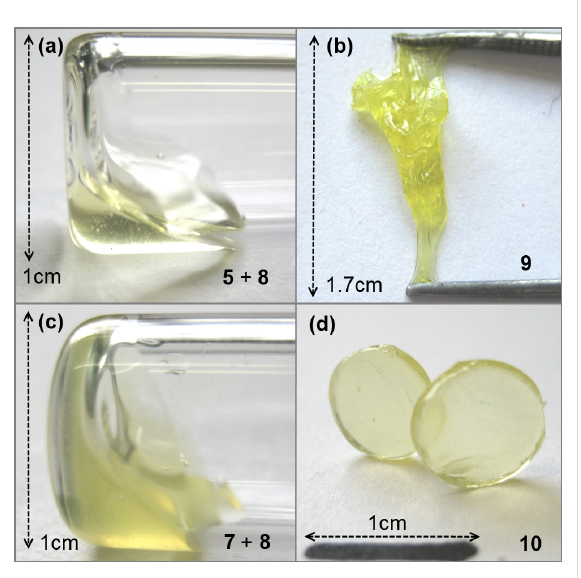
Figure 5: Illustration of the viscosity of a mixture of 5 and 8 (a), res- pectively 7 and 8 (c) before curing and the resulting materials 9 (b) and 10 (d), respectively after 24 h at 25 °C. 9 can be stretched easily by applying a force, whereas 10 can be shaped as a brittle disc.